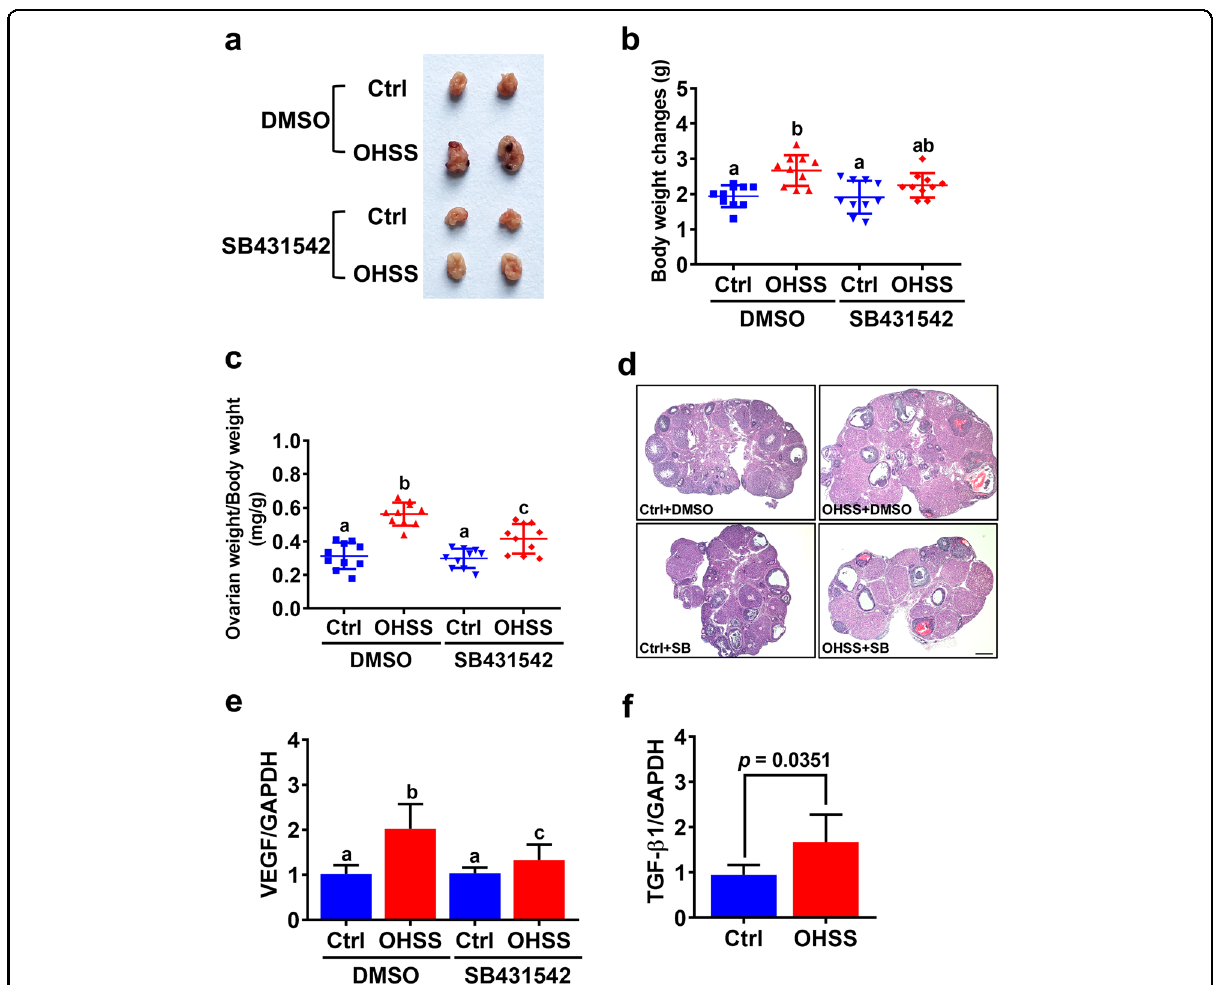
Fig. 6 Inhibition of TGF- β 1 signaling inhibits the pathogenesis of OHSS. a Representative ovaries from each group were photographed. b Changes in body weight throughout the treatments were determined after mice were euthanized. c Ovarian weight as it related to body weight was determined after mice were euthanized. d Images of representative H&E stained ovarian sections. Original magni fi cation. 40×, Scale bars represent 200 μ m. e , f VEGF ( e ) and TGF- β 1 ( f ) mRNA levels in mouse ovaries were examined by RT-qPCR. The results are expressed as the mean ± SD. The values without a common letter are signi fi cantly different ( p <